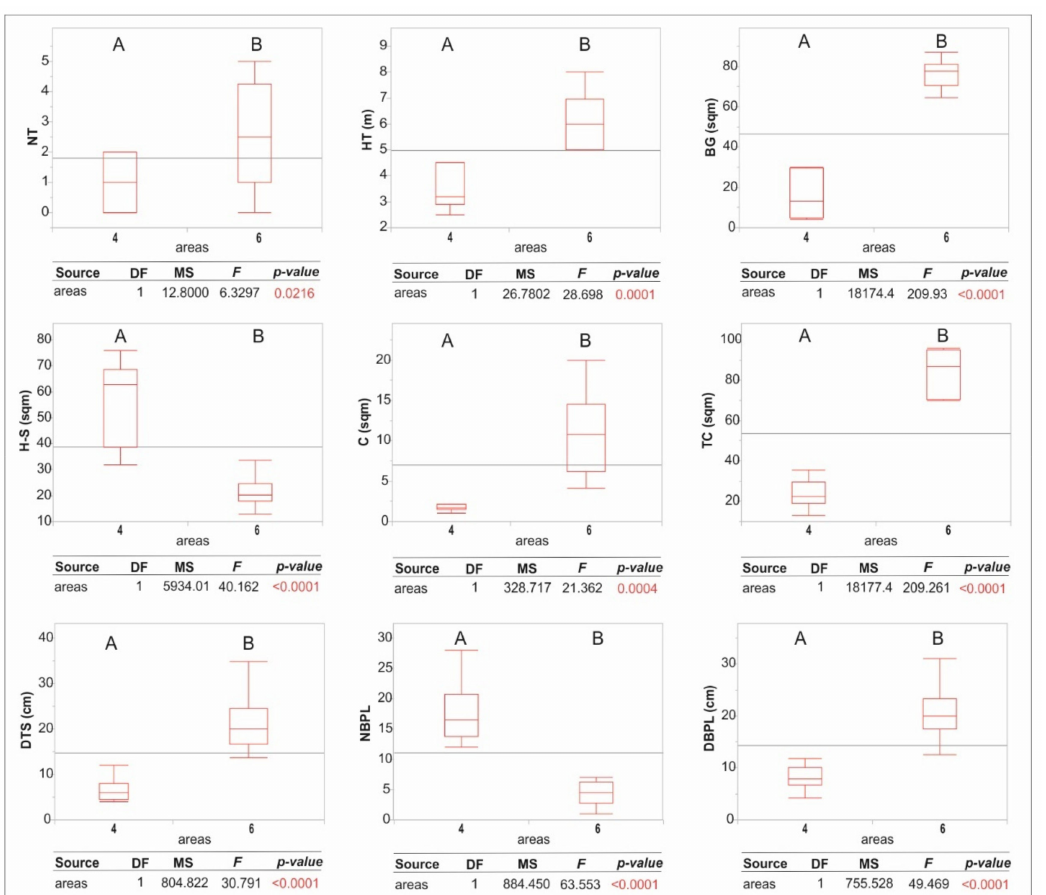
Figure 5. Box and whiskers ANOVA (limits of boxplots represent upper and lower quartiles, the central line is the median, whiskers indicate the highest and lowest observations) relating the different structural data between the two investigated areas. NT = number of trees; HT = height of trees; BG = coverage of bare ground; H-S = coverage of herbs and shrubs; C = coverage of trees crown; TC = total vegetation coverage; DTT = diameter of tree trunk; NBPL = number of burned pine logs (on the ground); DBPL = diameter of burned pine logs (on the ground). The different capital letters indicate significant differences between the means of each pair of measurements for different structural data (ANOVA according to Tukey’s HSD